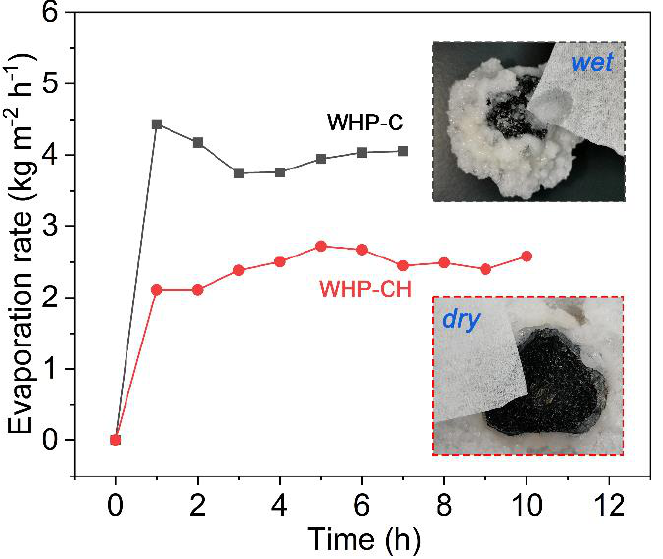
Figure 6. Water contact angles of ( a ) WHP, ( b ) WHP-C, and ( c ) WHP-CH. ( d , e ) Photos of WHP-C and WHP-CH after evaporating 30 wt% NaCl solution for 2 h under 4 sun irradiation, showing the good salt resistance of WHP-CH and the salt accumulation of the WHP-C.